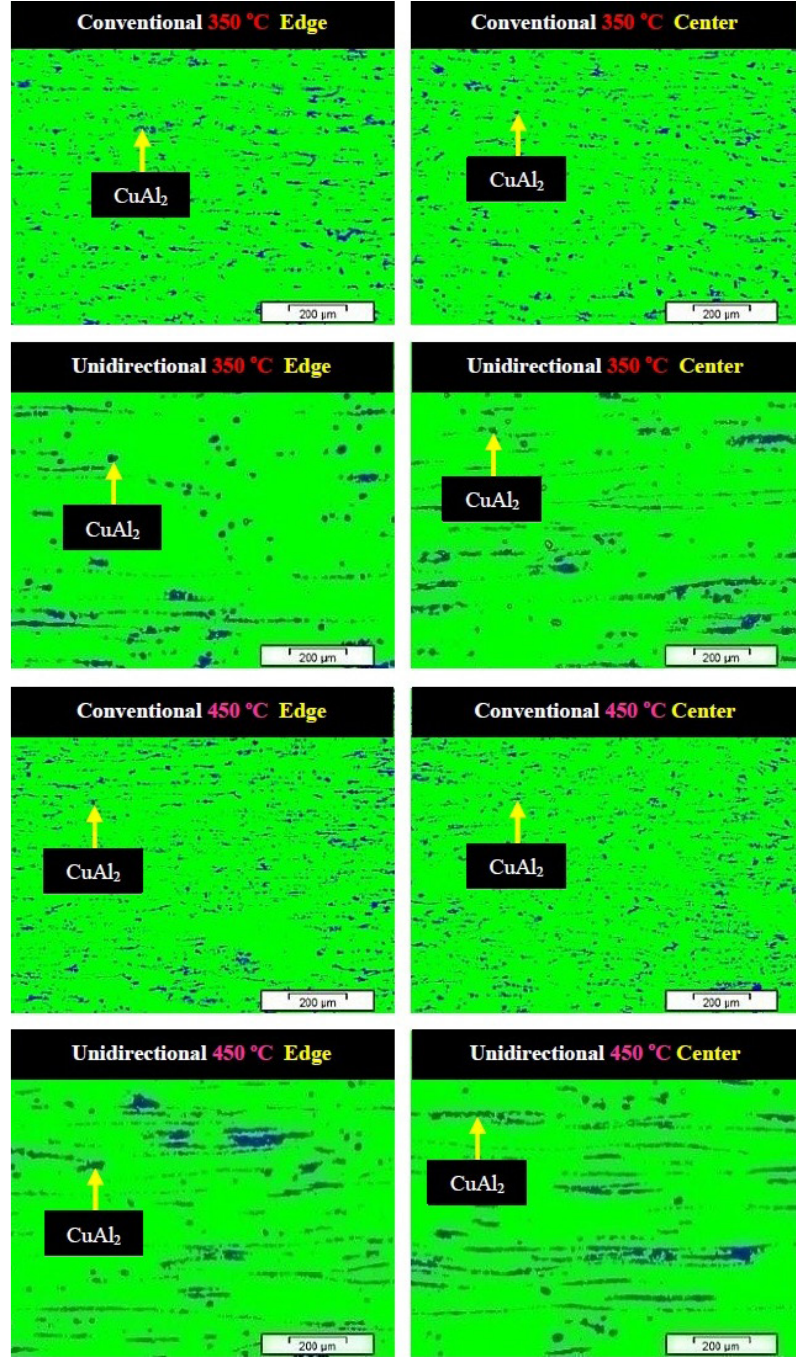
Figure 14. Density of precipitates at 350 and 450 ºC for the Al4.5wt%Cu alloy conventionally and unidirectionally solidified.